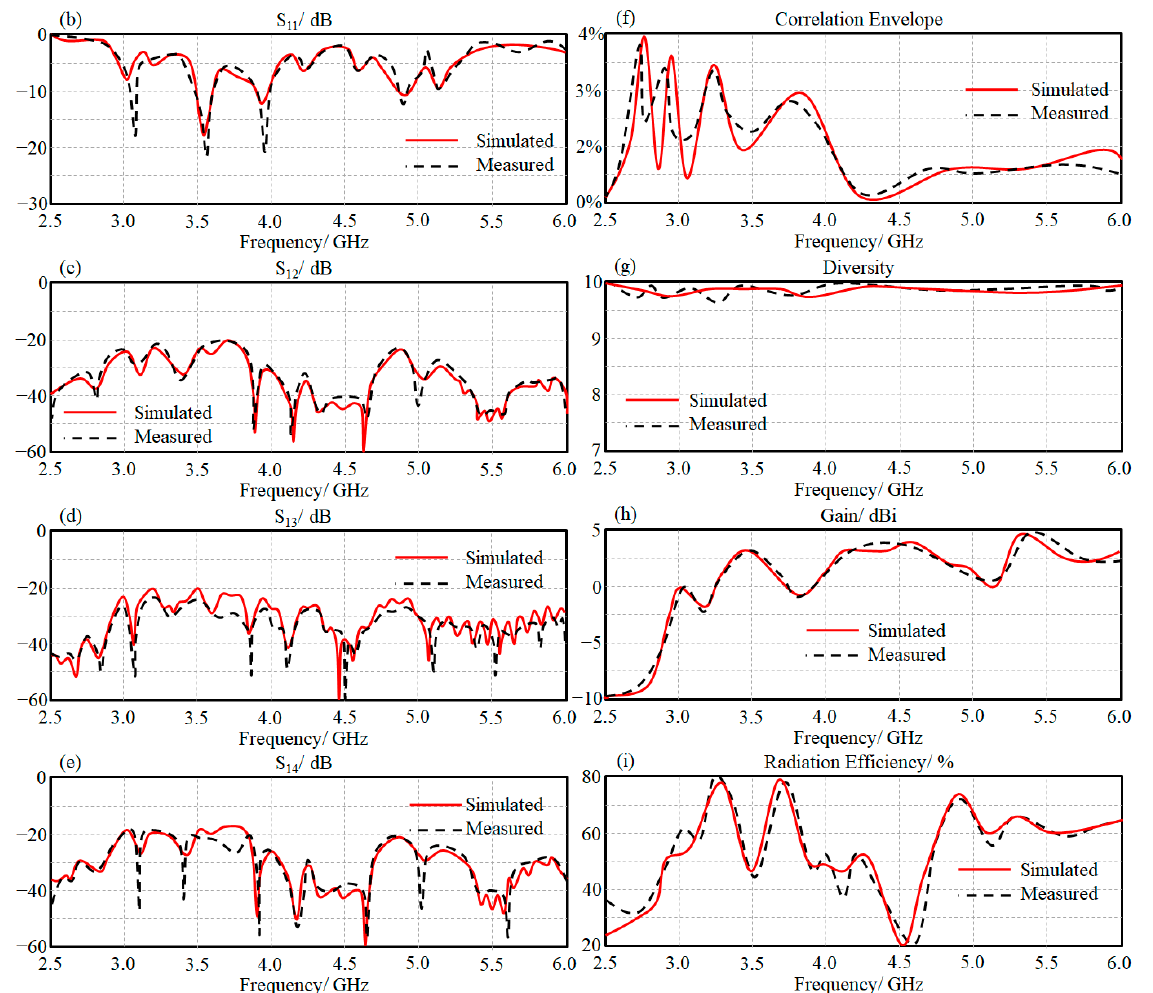
Figure 8. Experimental work: ( a ) fabricated prototype, ( b ) S 11 , ( c ) S 12 , ( d ) S 13 , ( e ) S 14 , ( f ) correlation envelop, ( g ) diversity envelope, ( h ) gain spectra, and ( i ) radiation efficiency.